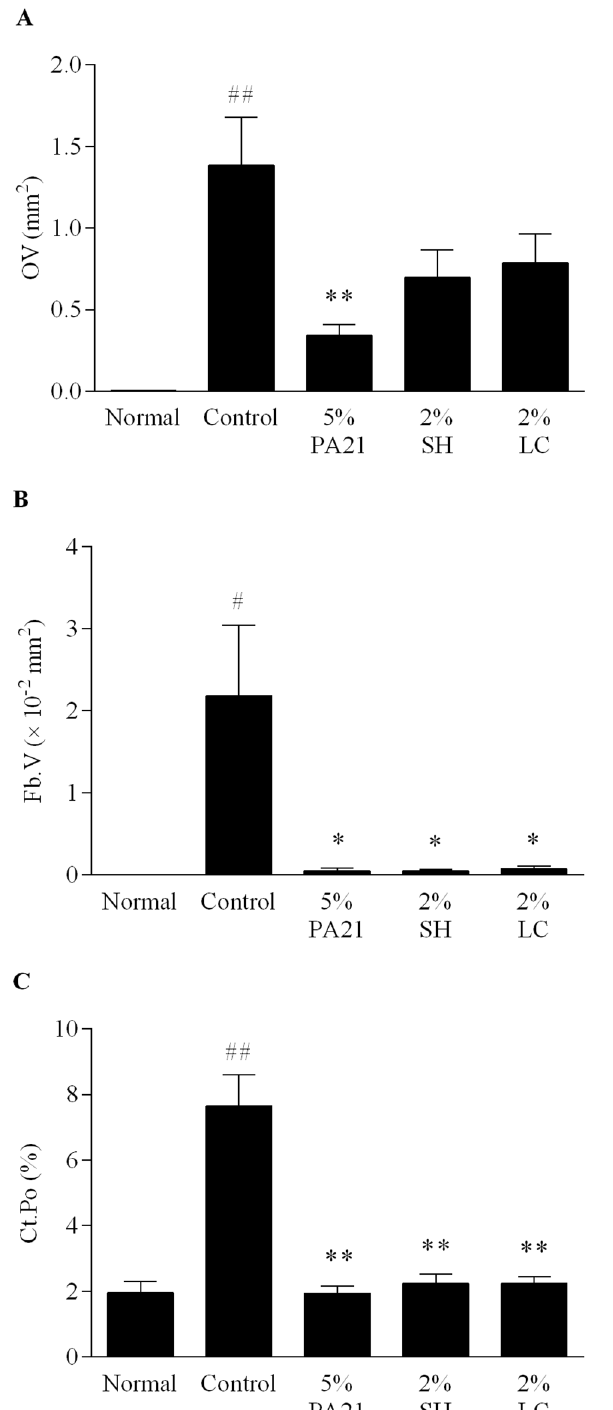
Fig 6. Effects of PA21, sevelamer hydrochloride, and lanthanum carbonate hydrate on (A) OV, (B) Fb. V, and (C) Ct.Po. Each column of the figures shows the mean value ± standard error of nine to 10 animals. SH, sevelamerhydrochloride; LC, lanthanum carbonate hydrate. # P < 0.05 and ## P < 0.01, Aspin-Welch’s t- test betweenthe normal and control groups. * P < 0.05 and ** P < 0.01, Aspin-Welch’s t-test betweenthe control and the investigateddrug administered